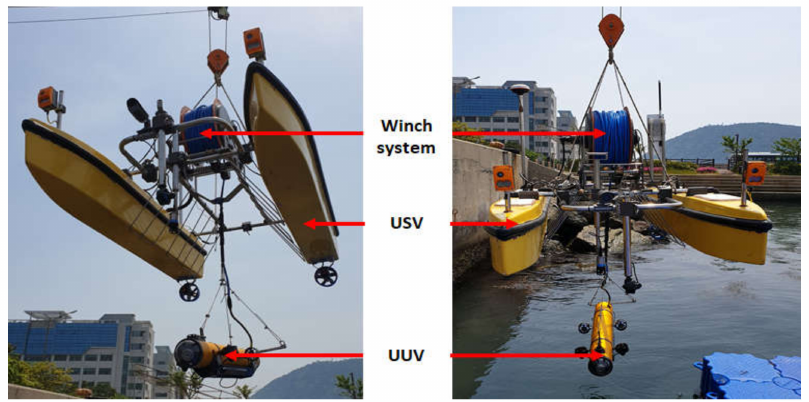
Figure 3. Configuration of the integrated